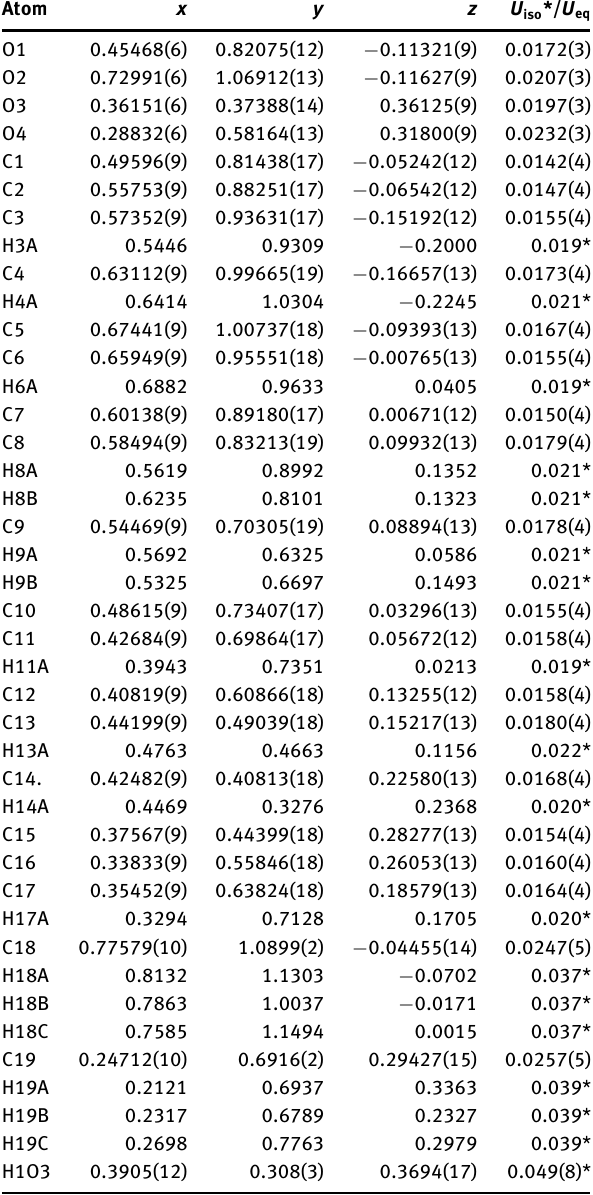
Table 2: Fractional atomic coordinates and isotropic or equivalent isotropic displacement parameters (Å 2 ).